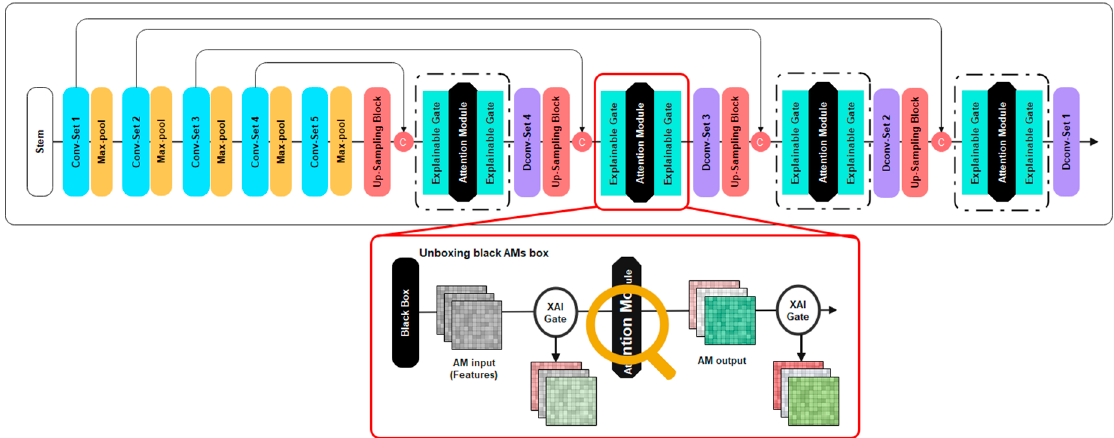
Figure 1. Overall framework of the proposed method. In the decoder part, four attention blocks and eight explainable gates are designed to evaluate the effect of AMs on different backbones and explain their black box.